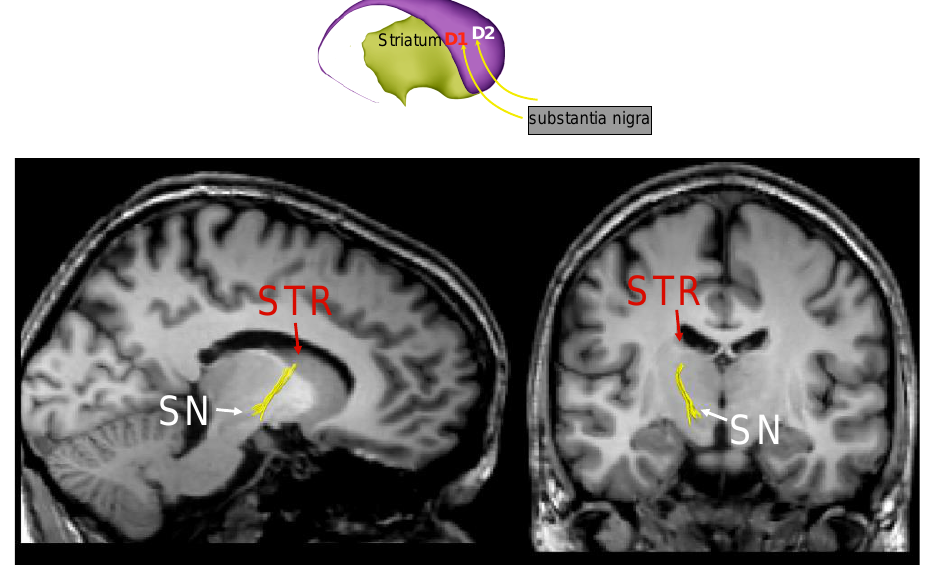
Figure 1. The fronto-striatal circuit (part a).